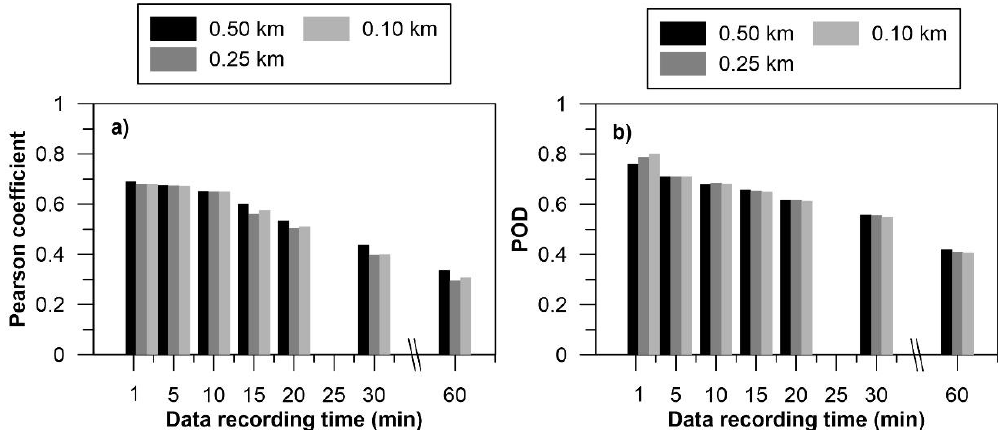
Figure 8. Variation of the Pearson correlation coefficient ( a ) and the probability of detection index ( b ) according to the sampling time and pixel resolution.